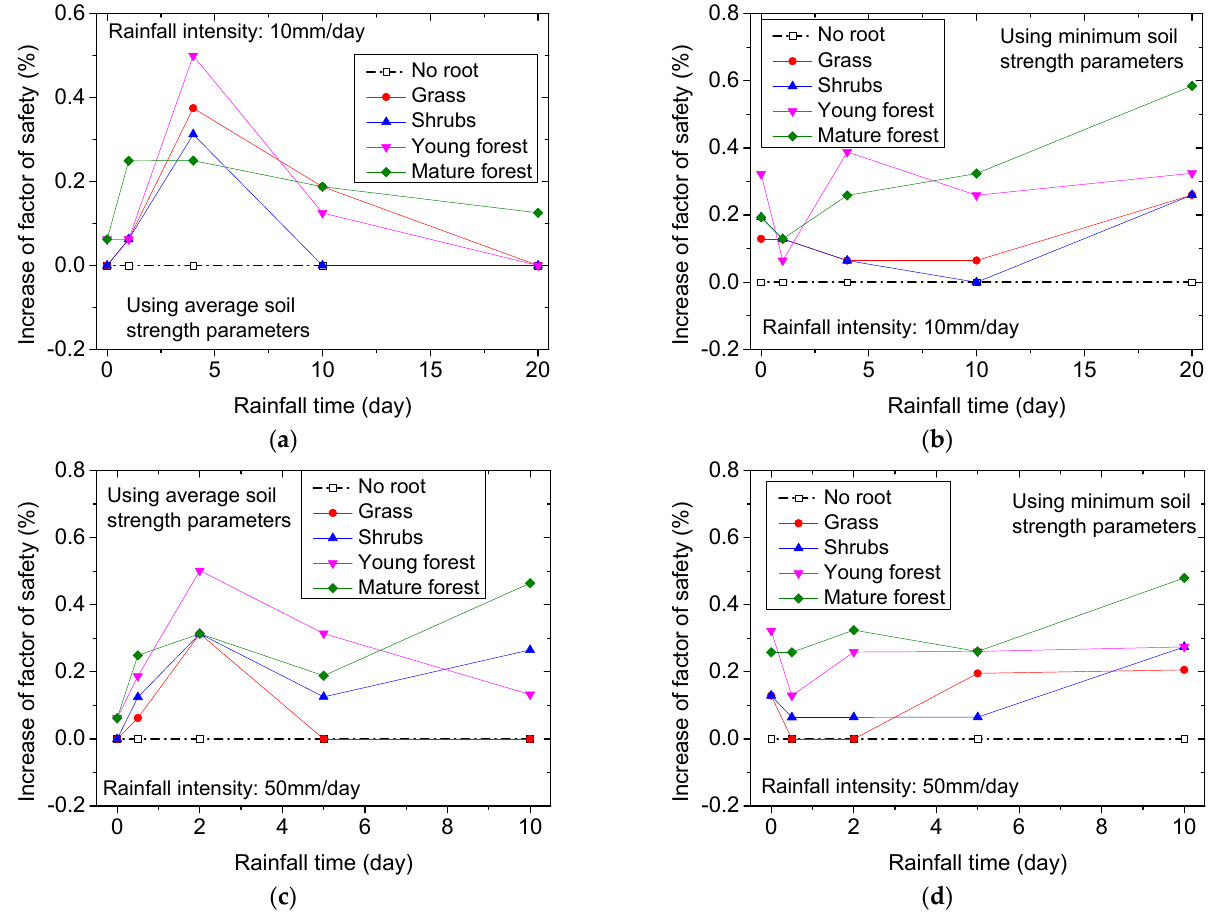
Figure 12. Increase of factor of safety of the slope with different rainfall conditions and soil strength parameters: ( a ) 10 mm/day rainfall and average soil strength parameters; ( b ) 10 mm/day rainfall and minimum soil strength parameters; ( c ) 50 mm/day rainfall and average soil strength parameters; ( d ) 50 mm/day rainfall and minimum soil strength parameters.